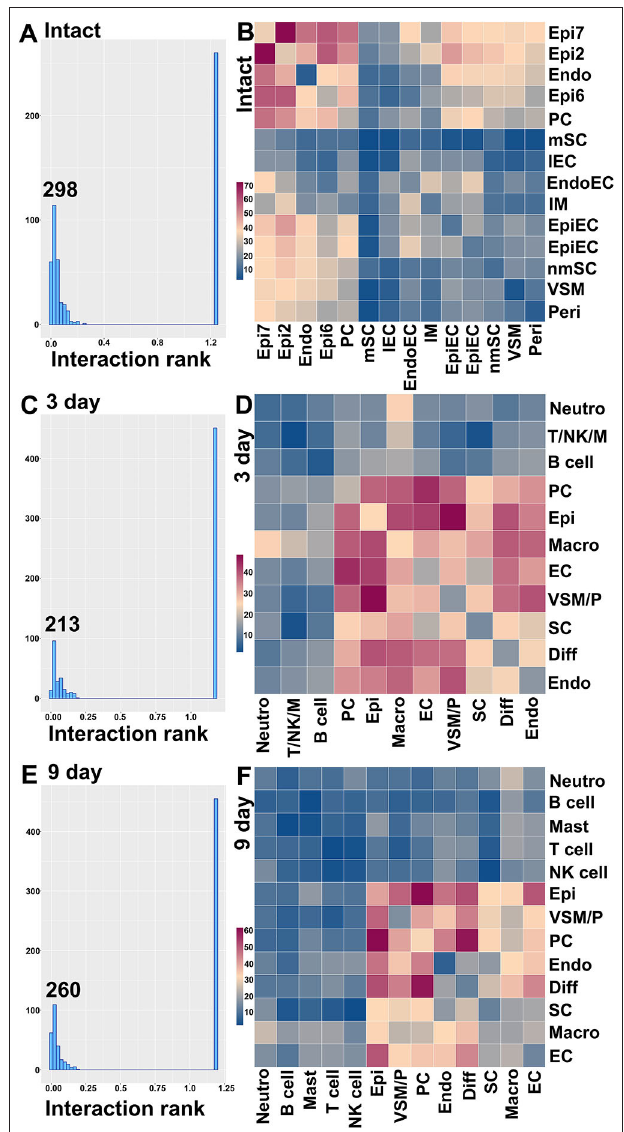
FIGURE 11 | Ligand-receptor interactions between the cell clusters in intact and injuried nerves. (A) Distribution of CellphoneDB interaction rank for intact nerves. 298 significant ligand-receptor interactions were identified. (B) Heatmap of number of ligand-receptor interactions between the cell clusters in intact nerves. (C) Distribution of CellphoneDB interaction rank for the distal nerve at day 3 post-injury. Two hundred and thirteen significant ligand-receptor interactions were identified. (D) Heatmap of number of ligand-receptor interactions between the cell cluters in the distal nerve at day 3 post-injury. (E) Distribution of CellphoneDB interaction rank for the distal nerve at day 9 post-injury. Two hundred and sixty significant ligand-receptor interactions were identified. (F) Heatmap of number of ligand-receptor interactions between the cell clusters in the distal nerve at day 9 post-injury. Endo, Endoneurial fibroblasts; PC, Perineurial cells; Epi, Epineurial fibroblasts; SC, Schwann cells; nmSC, non-myelinating Schwann cells; mSC, Myelinating Schwann cells; EC, Endothelial cells; EpiEC, Epineurial endothelial cells; EndoEC, Endoneurial endothelial cells; lEC, Lymphatic endothelial cells; Peri, Pericytes; VSM, Vascular smooth muscle cells; VSM/P, Vascular smooth muscle cells and Pericytes. IM, Immune cells. Neutro, Neutrophils; Macro, Macrophages; T/NK/M, T, NK and mast